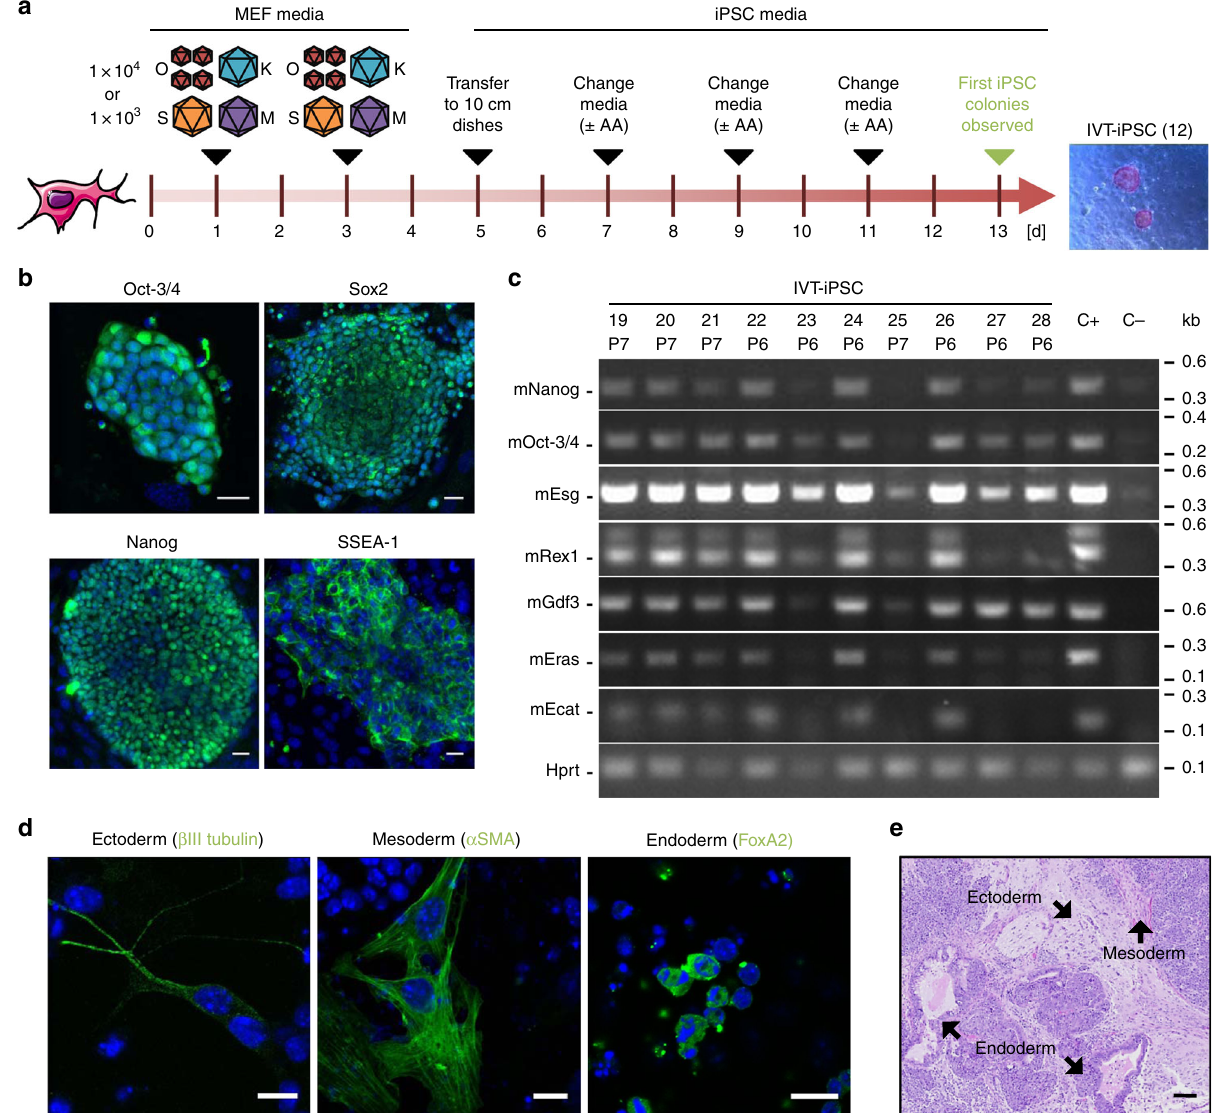
Fig. 1 In vitro reprogramming of MEF using AAV-DJ SFFV-hCO-O/K/S/M vectors. a Experimental setup. MEF were transduced at days 1 and 3 after plating with the four vectors, using a 4:1:1:1 O:K:S:M stoichiometry and one of the two indicated MOIs per experiment and per vector (with a four-fold excess of Oct-3/4). At day 5, cells were transferred from a well of a 6-well plate to a 10 cm dish. Subsequently, medium was changed every other day to iPSC medium with or without ascorbic acid (AA). First colonies with iPSC morphology were observed at day 13. The image shows a representative alkaline phosphatase staining of clone IVT-iPSC 12 at passage 1. n = 4 for MOI 1 × 10 4 and n = 3 for MOI 1 × 10 3 . b Confocal images exemplifying expression of Oct- 3/4, Sox2, Nanog and SSEA-1 in AAV-derived iPSC (again IVT-iPSC 12). Shown are merges of Hoechst and secondary antibody (Alexa Fluor 488-labeled) stainings. Scale bars = 20 µ m. c Reverse transcription-PCR analysis to detect expression of the depicted pluripotency markers. Shown are 10 representative clones from the reprogramming series with ascorbic acid. See Supplementary Data 1 (tab “ In vitro ” ) for details. Six of the ten shown clones (IVT-iPSC 19 to 22, 24, and 26) are positive for all markers. Hprt (Hypoxanthine-guanine phosphoribosyltransferase) served as housekeeper. C + iPSC generated with a lentiviral vector encoding human codon-optimized OKSM (positive control); C − untreated MEF (negative control); P, passage number. d Confocal images showing expression of ectodermal, mesodermal, and endodermal markers in differentiated clone IVT-iPSC 1. Shown are merges of Hoechst and secondary antibody (Alexa Fluor 488-labeled) stainings. Scale bars = 13 µ m. Confocal images in b and d were taken with a Leica SP5 microscope with a ×40 oil immersion objective and processed with ImageJ. e Hematoxylin/eosin staining of a section of a subcutaneous teratoma generated in mice via injection of clone IVT-iPSC 1. Structures belonging to the three embryonic germ layers are indicated by black arrows. Scale bar = 100 µ m. This fi gure contains elements from Servier Medical Art